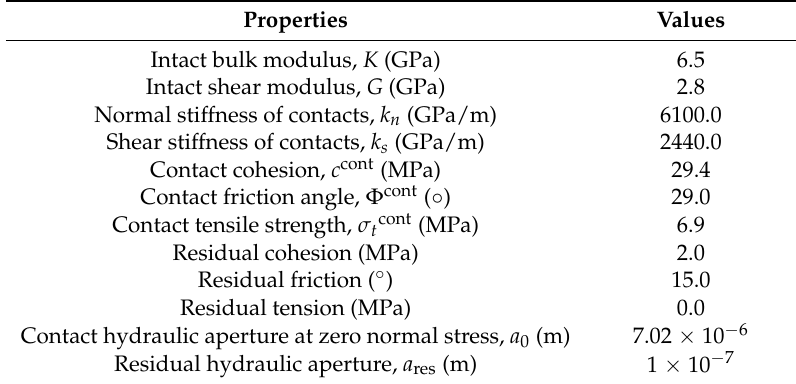
Figure 7. Calibration of the numerical model to the Brazilian tests: ( a ) failure pattern of the laboratory sample; ( b ) failure pattern of the numerical model; and ( c ) stress–strain curve of the numerical model. Table 1. Mechanical parameters obtained by sample fitting with the numerical model.